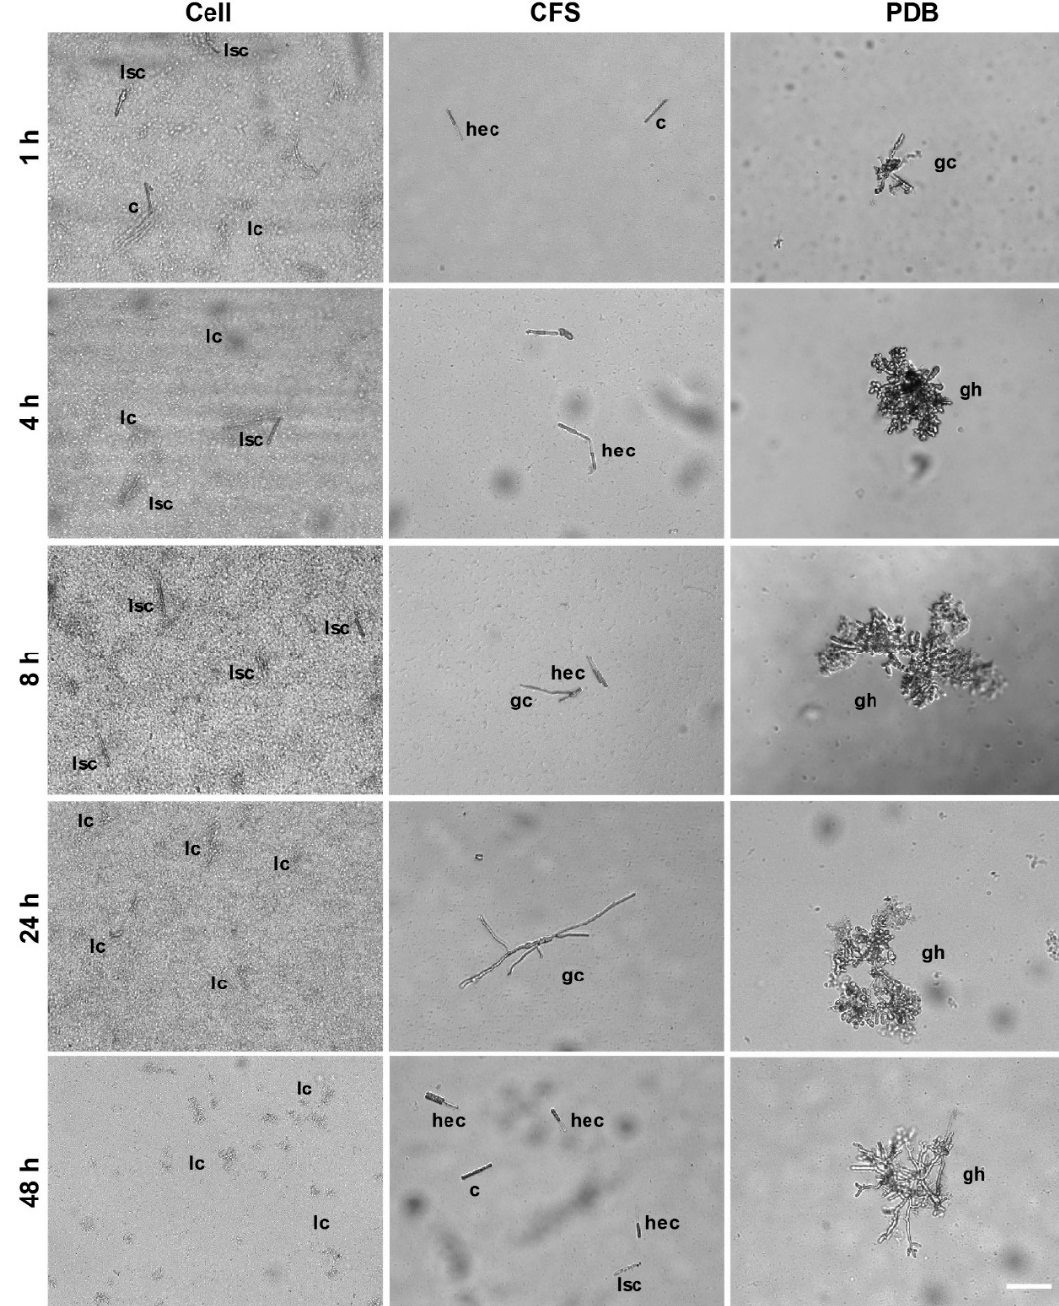
Figure 2. Micrographs of conidia morphology of Calonectria pseudonaviculata after being incubated in SSG cell suspension at 10 7 cfu/mL (Cell), cell-free supernatant (CFS), or potato dextrose broth (PDB): c = conidium, lsc = lysing conidium, lc = lysed conidium, hec =half empty conidium, gc = germinating conidium, gh = growing hyphae from conidial germling. Bar = 50 µm.